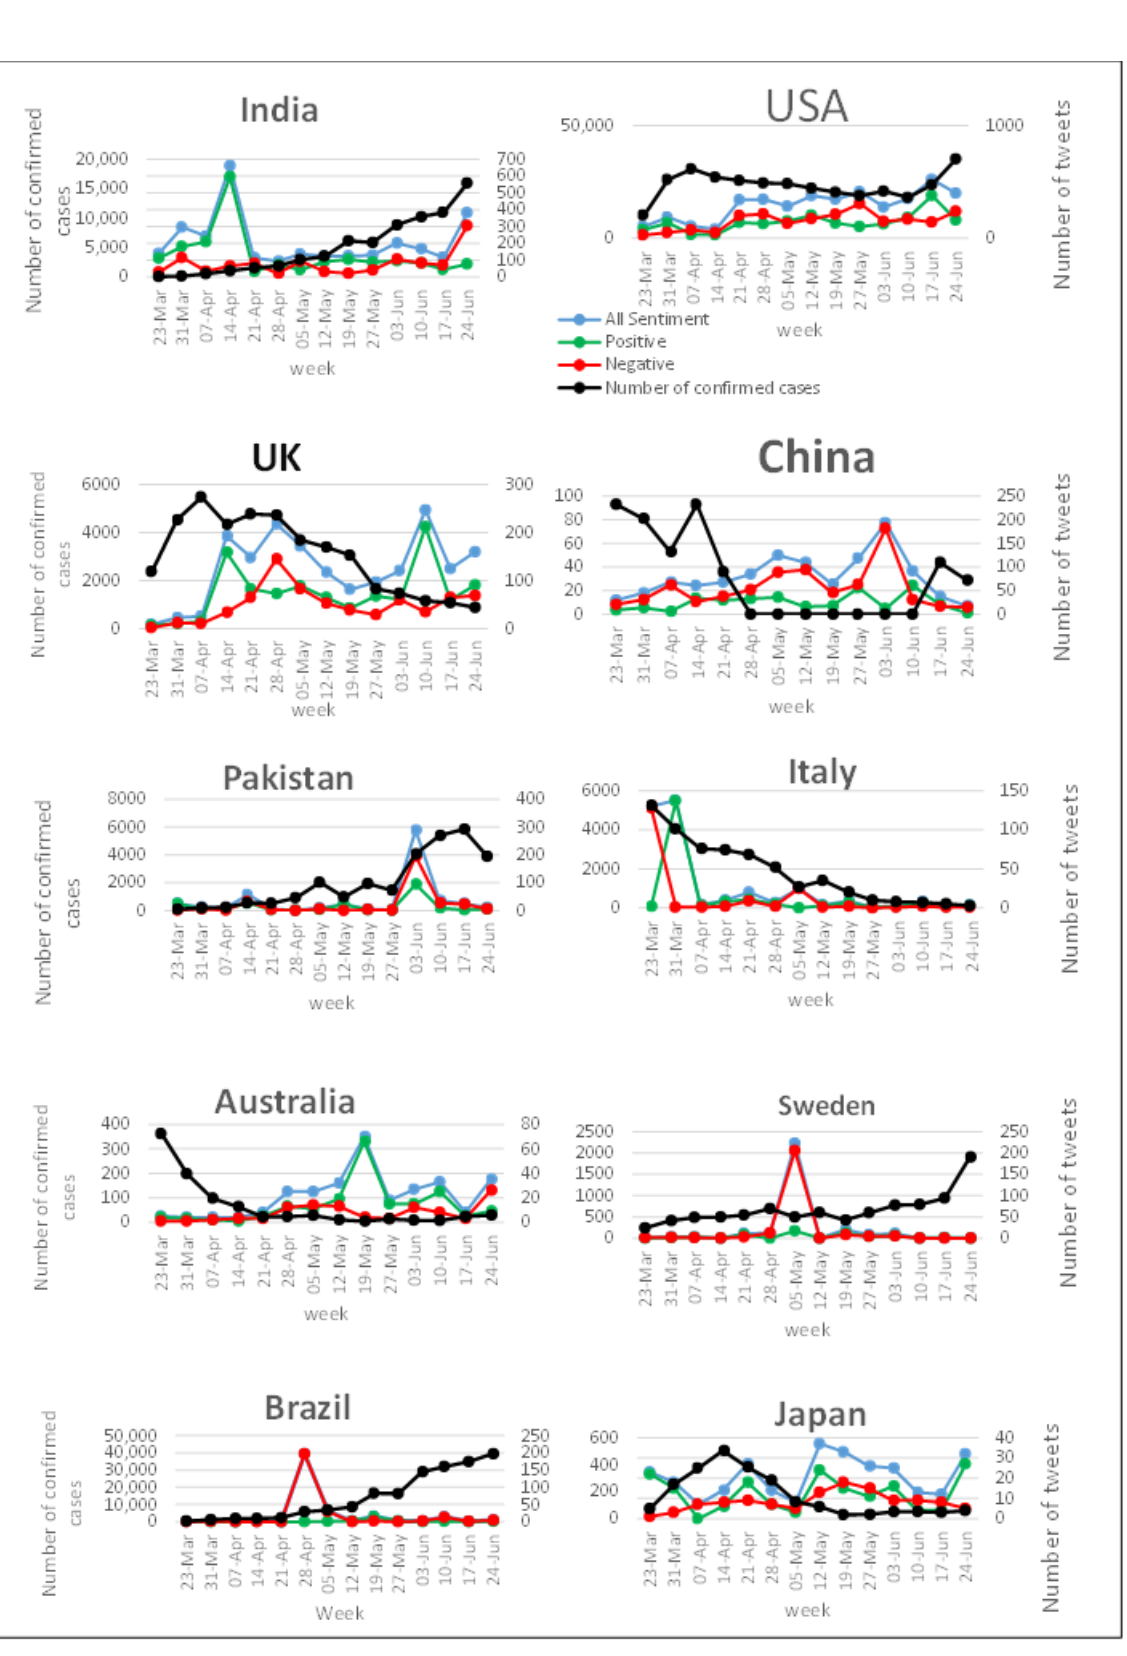
Figure 6. Frequency of all, positive, and negative tweets, and official COVID-19 cases for several countries.